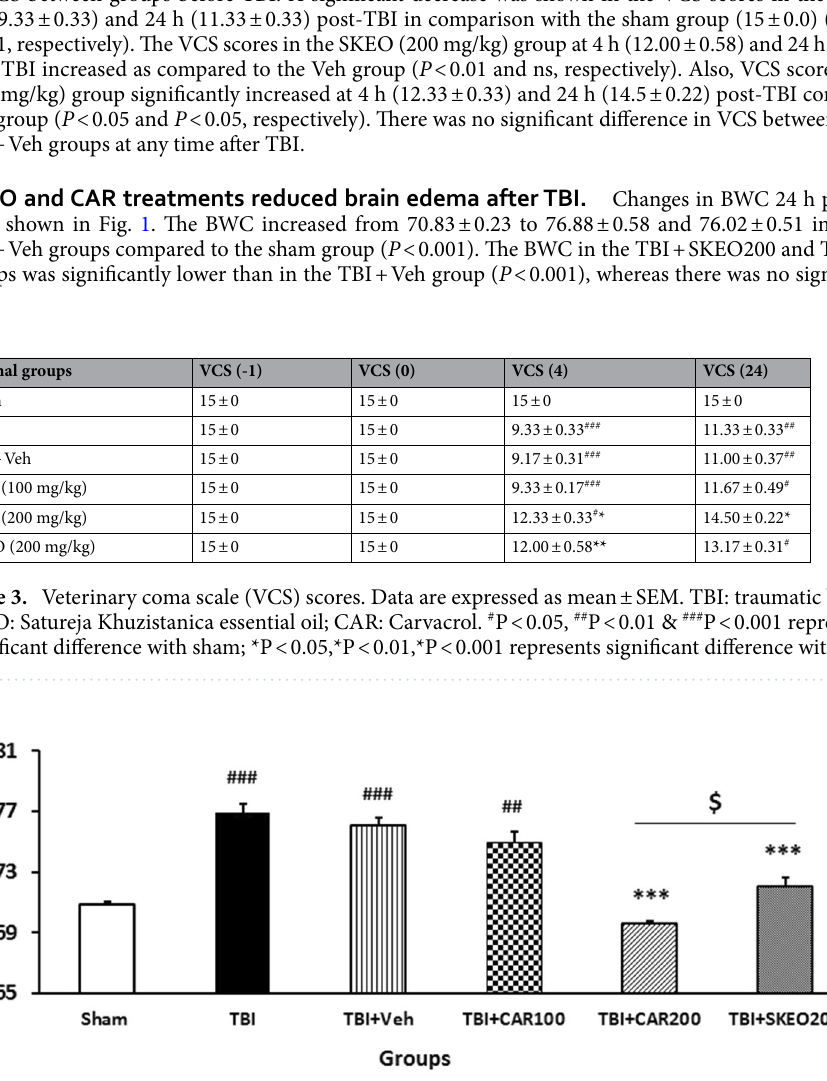
Figure 1. Effects of SKEO and CAR on the percent of brain water content 24 h after TBI induction in the different experimental groups (n = 6 rats per group). Data are expressed as mean ± SEM. ## P < 0.01 and ### P < 0.001 represents significant difference with sham; *** P < 0.001 represents significant difference with TBI + Veh; and $ P < 0.05 represents significant difference with TBI + SKEO. TBI: Traumatic brain injury; SKEO: Satureja khuzistanica essential oil; CAR: